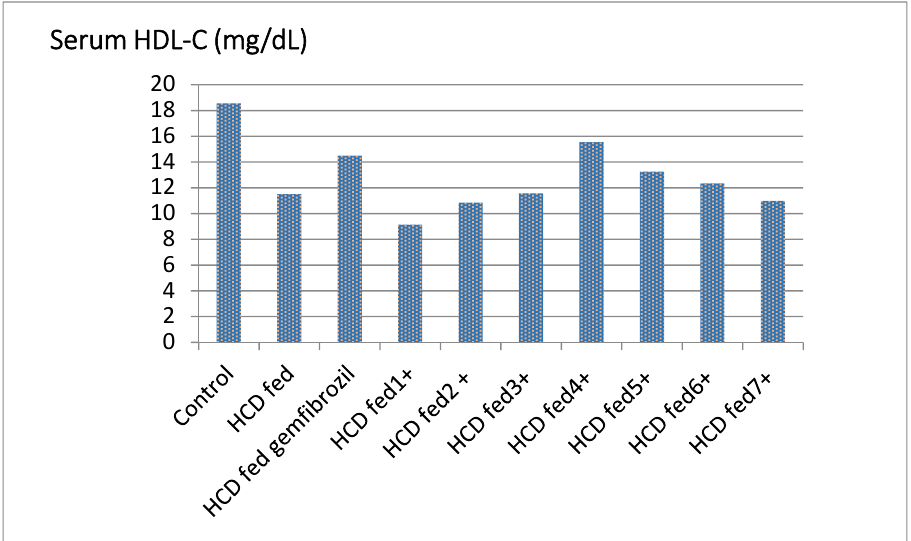
Figure 4. Effect of the tested compounds and gemfibrozil on serum LDL-C of hyperlipidemic rats.